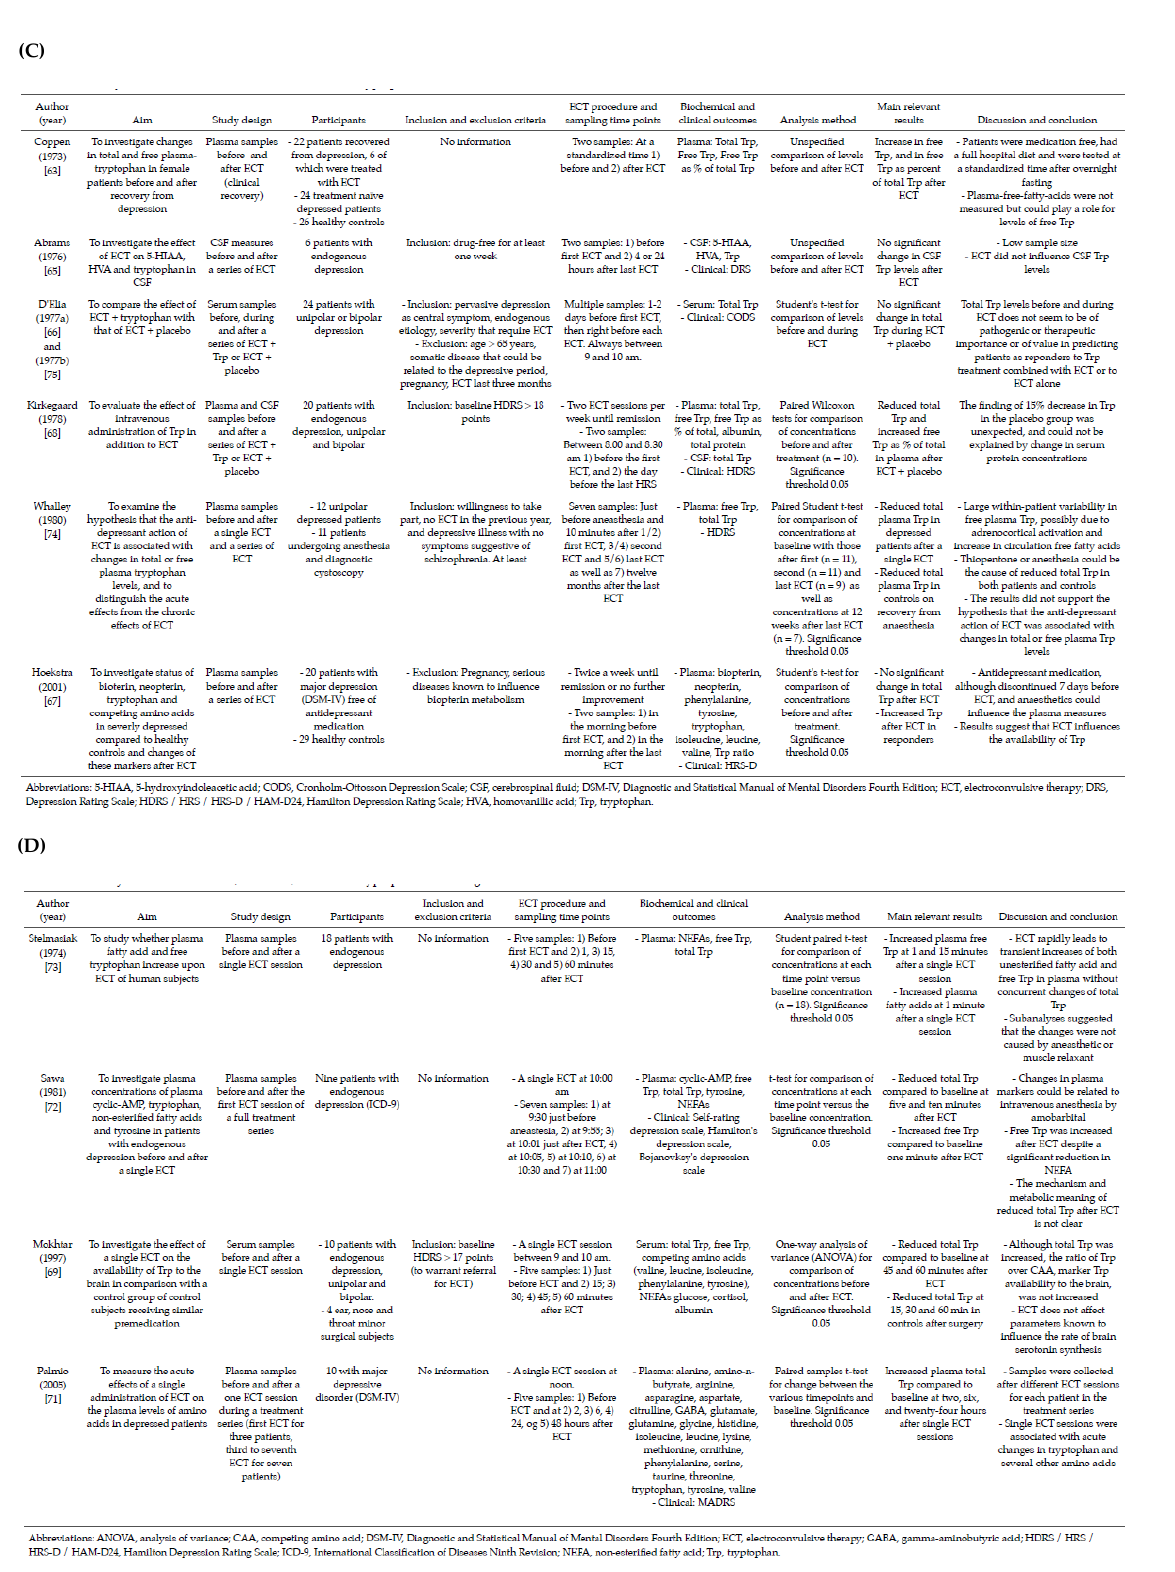
Figure 3. ( A , B ) Summary of included studies: Studies of tryptophan and kynurenines after a series of ECT. ( C ) Summary of included studies : Studies of tryptophan after a series of ECT. ( D ) Summary of in-cluded studies : Studies of tryptophan after a single